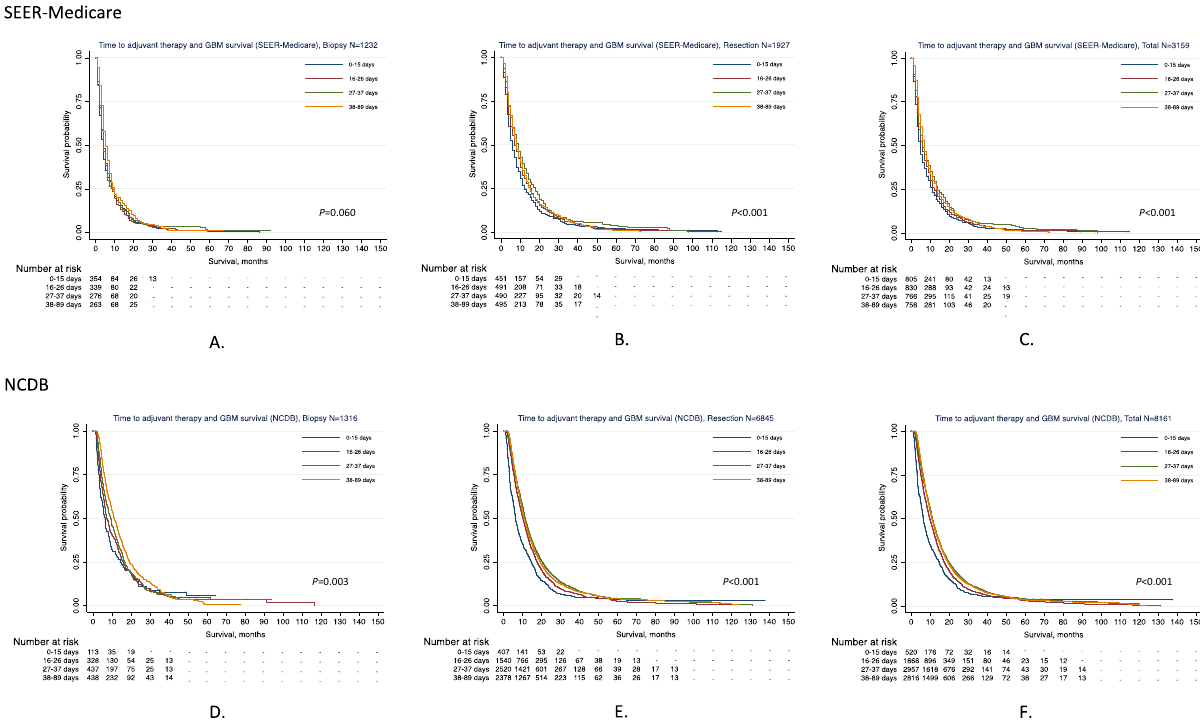
Figure 1. OS of GBM patients across time to AT (four-category) by applying the Kaplan–Meier method. *“−” was used when the number of patients was 11 or fewer based on privacy policy of both SEER-Medicare and NCDB. ( A ) OS of GBM across time to AT in patients undergoing biopsy from SEER-Medicare. ( B ) OS of GBM across time to AT in patients undergoing resection from SEER-Medicare. ( C ) OS of GBM across time to AT among total patients from SEER-Medicare. ( D ) OS of GBM across time to AT in patients undergoing biopsy from NCDB. ( E ) OS of GBM across time to AT in patients undergoing resection from NCDB. ( F ) OS of GBM across time to AT among total patients from